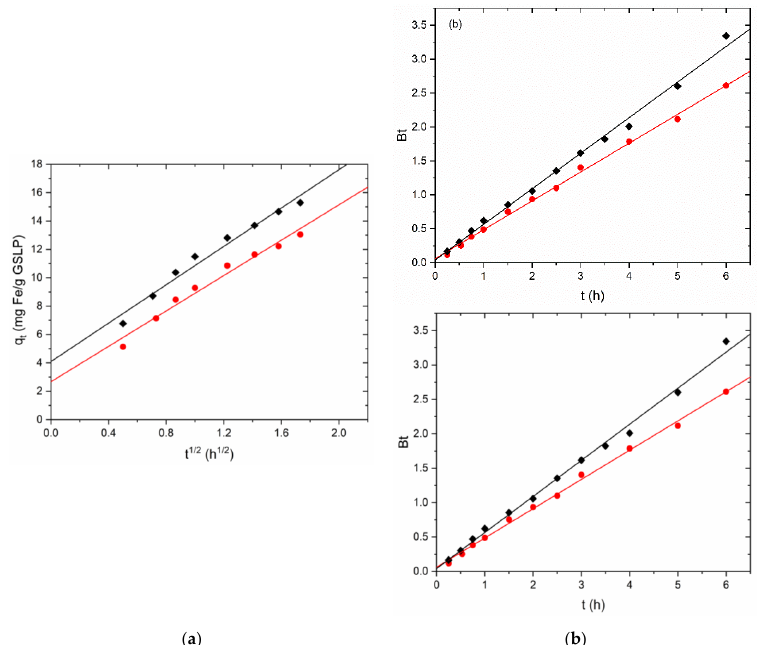
Figure 5. ( a ) Linearized adsorption kinetics of Fe(II) sorption by GSLP D3 ( ● ) and GSLP D2 ( ♦ ) using the Webber – Morris model. ( b ) Linearized Fe adsorption kinetics of Fe(II) sorption by GSLP D3 ( ● ) and GSLP D2 ( ♦ ) using the Boyd model. GSLP dose of 2 g·L − 1 , natural pH (ca. 5), room temperature, and stirring at 200 RPM.